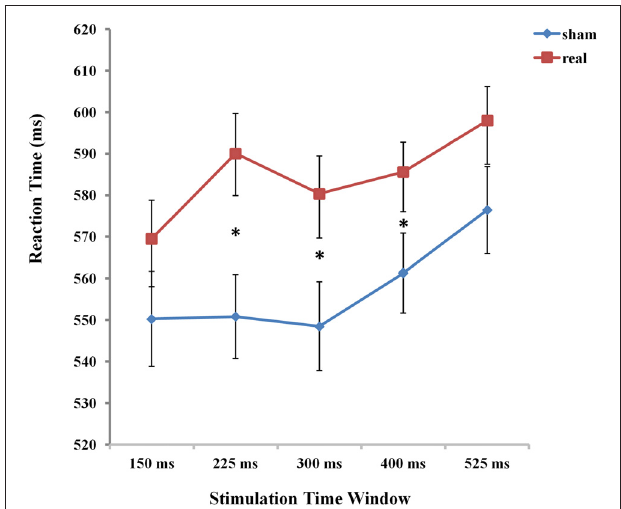
FIGURE 4 | The mean reaction times (RTs) of the five time windows in real and sham stimulation conditions. An asterisk means p < 0.05 (Bonferroni